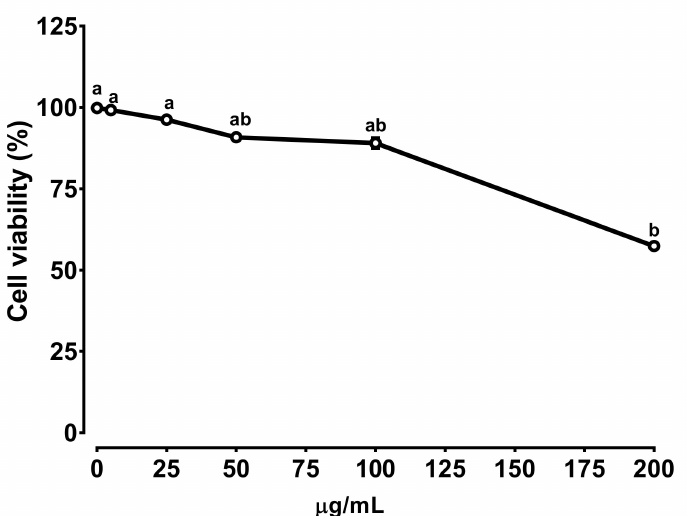
Figure 1. Cell viability of BE-treated HepG2 cells. Cells were treated with increasing concentrations from 0 to 200 µ g/mL of BE for 24 h. Different letters on the data points represent significant differences ( p < 0.05). Values are means ± S.E.M. n =